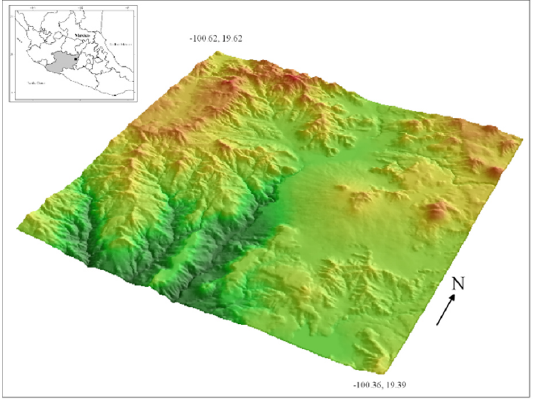
Figure 1 . Situation map and block of the study area.